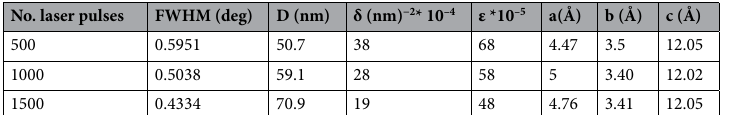
No. laser pulses